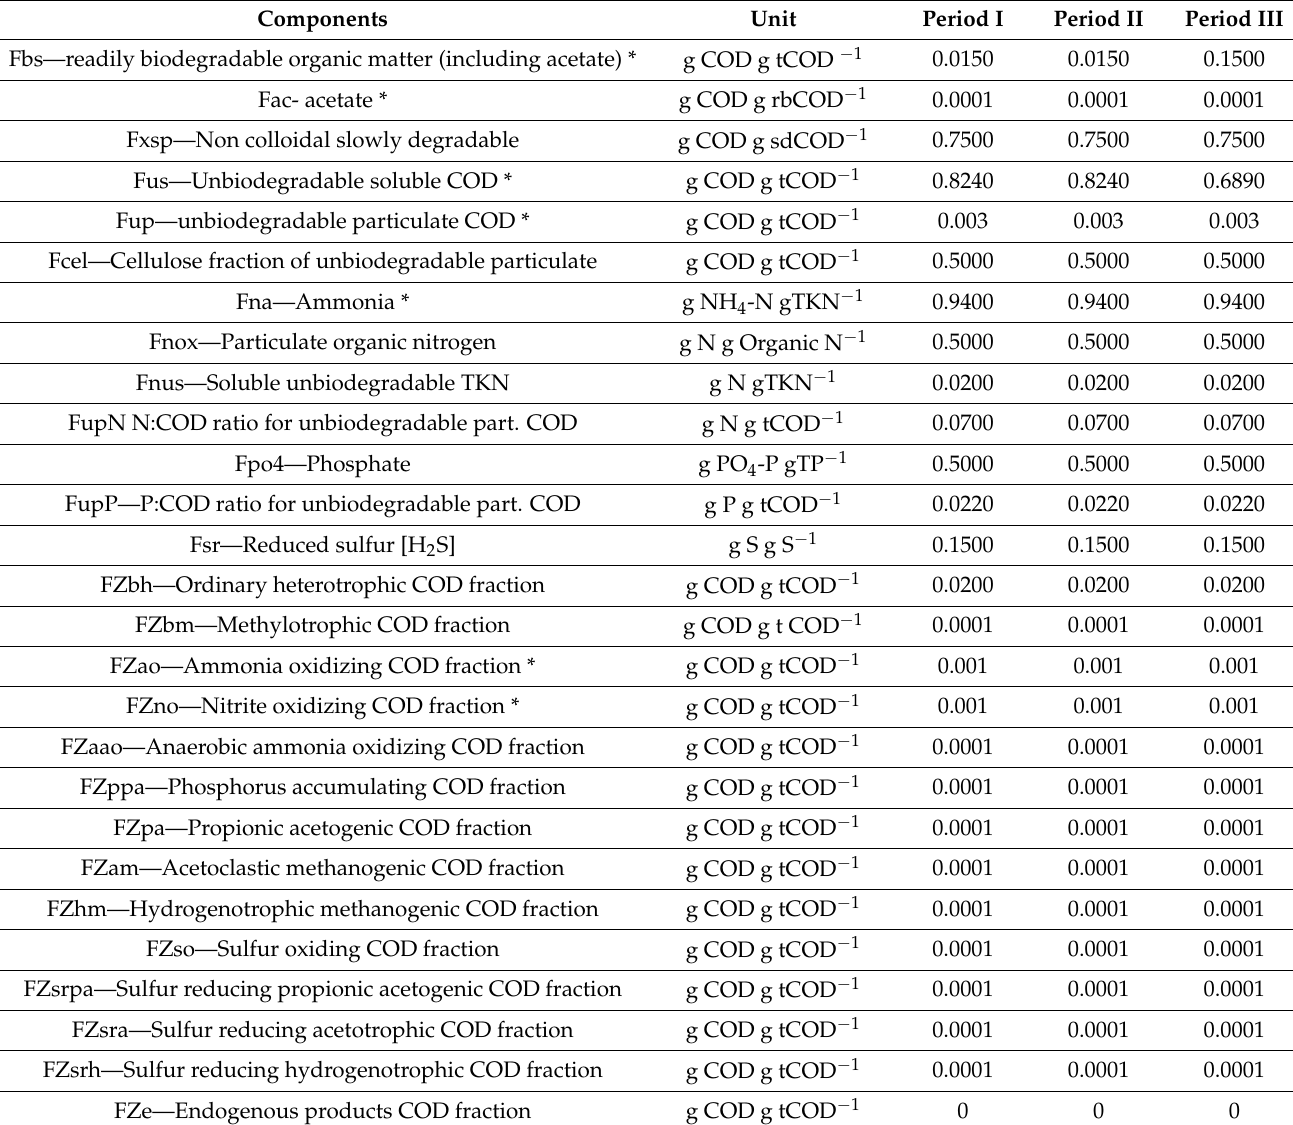
Table 3. Leachate fractions used in BioWin